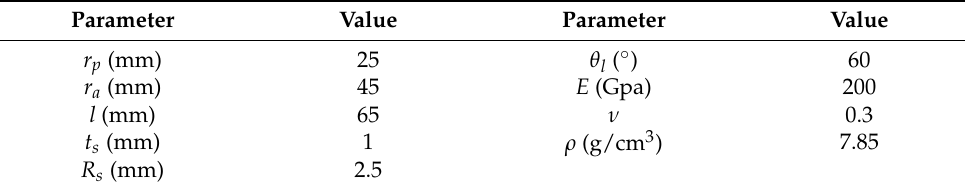
Table 1. Dimension parameters and material characteristics of the micromanipulator. Parameter Value